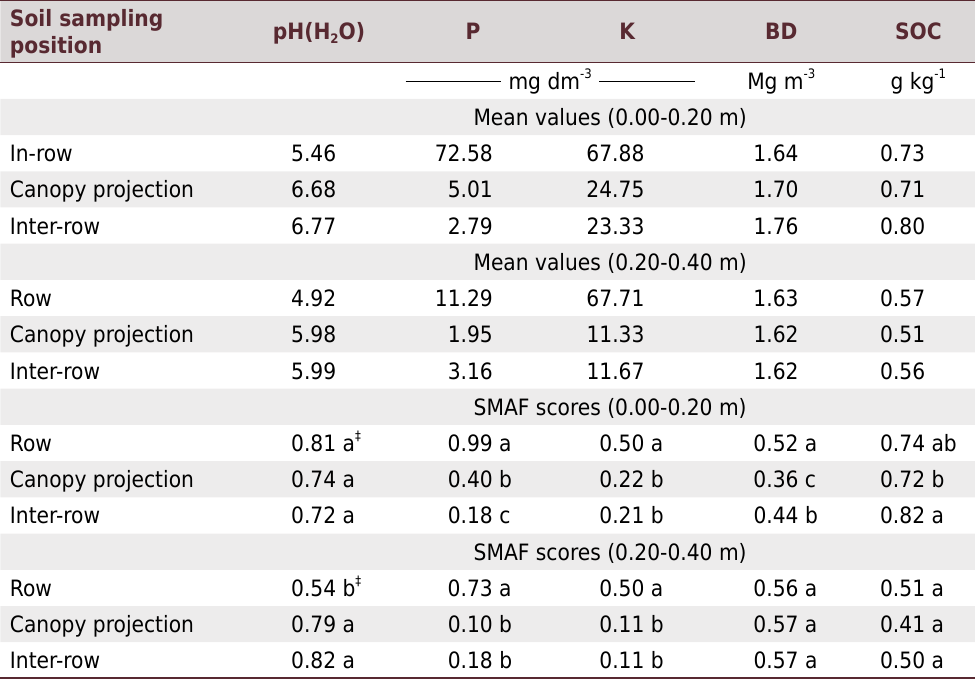
pH(H 2 O): pH in water, 1:2.5 v/v; P and K: extracted by Mehlich-1; BD: bulk density, SOC: soil organic carbon. ‡ Mean scores in the column within each depth followed by the same letter do not differ among